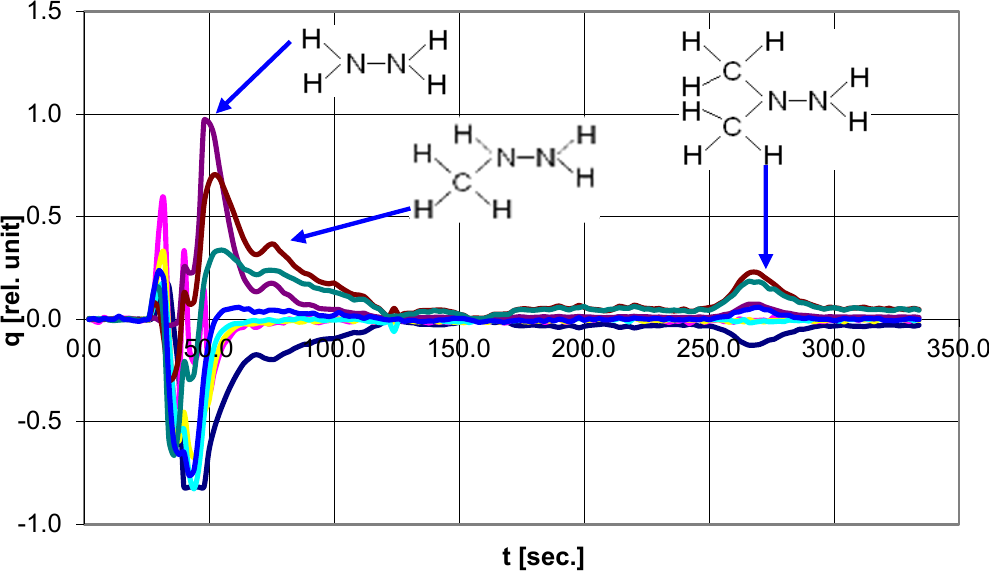
Figure 7. 2D chromatogram obtained by scanning coulometry.